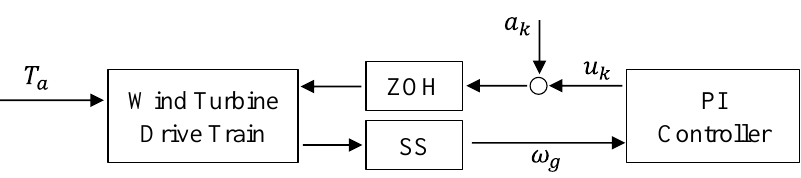
Figure 4. Wind turbine control system under the zero–dynamics attack at the actuator side. ZOH— zero-order hold; SS—simple sampler;